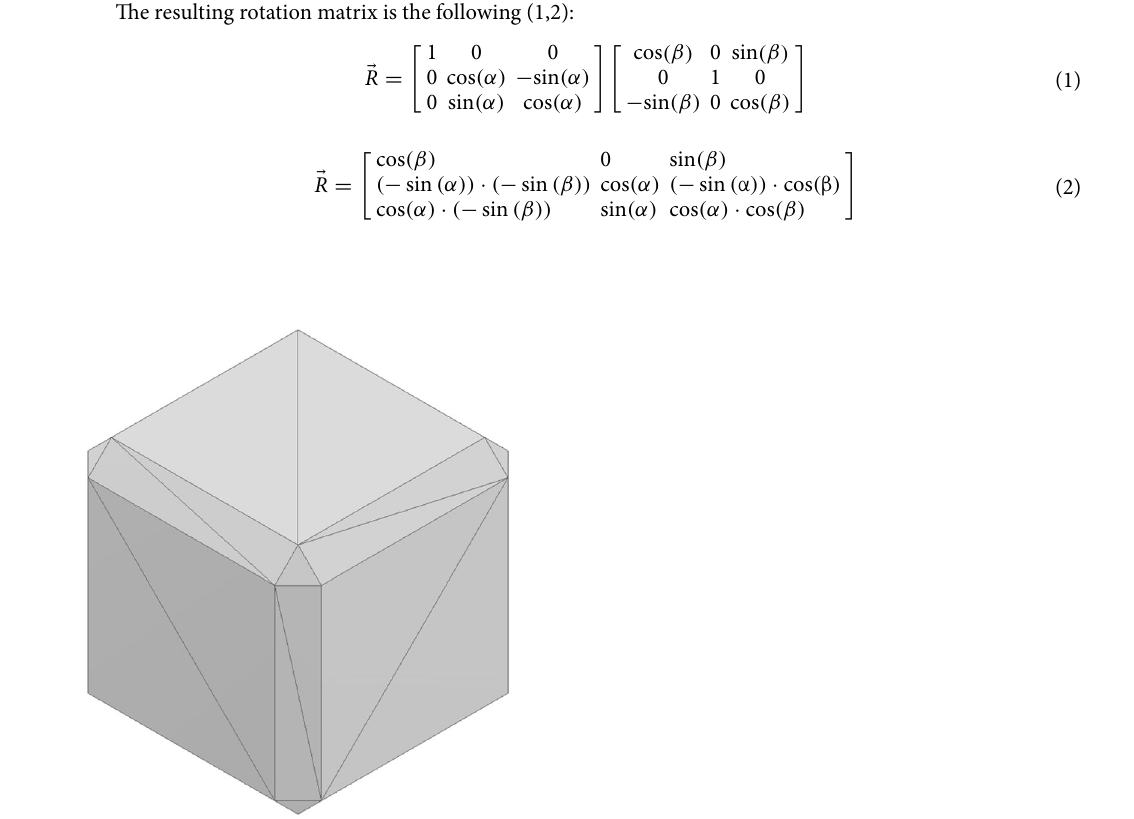
Figure 2. STL representation of cube with fillets on the